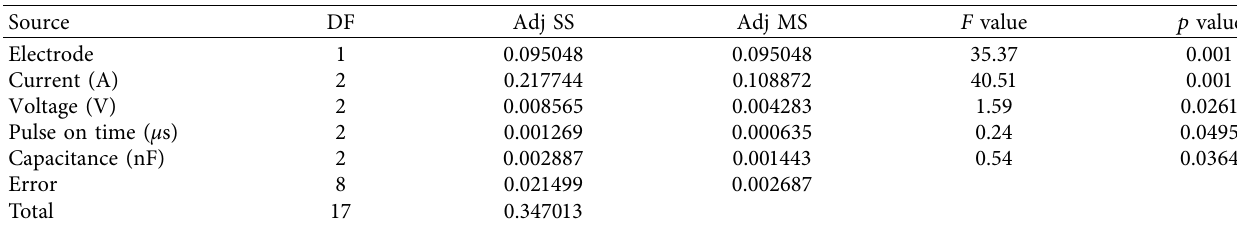
Figure 1: The MRR response with the variation of (a) input current, (b) voltage, (c) pulse on time, and (d) capacitance. Table 6: ANOVA of